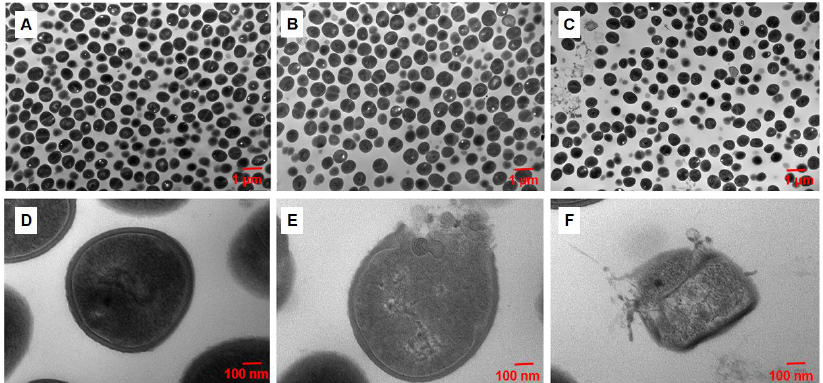
Figure 4. Morphology of MRSA (USA 300) under transmission electron microscopy. ( A , D ) show the morphology of USA 300 strain in the control group without compound TD4 treatment, respectively. ( B , E ) are the morphology of USA 300 strains treated by 4 µ g/mL TD4, respectively. ( C , F ) are the morphology of USA 300 strains treated by 8 µ g/mL TD4, respectively. ( A – C ): scale bar = 1 µ m, ( D – F ): scale bar = 100